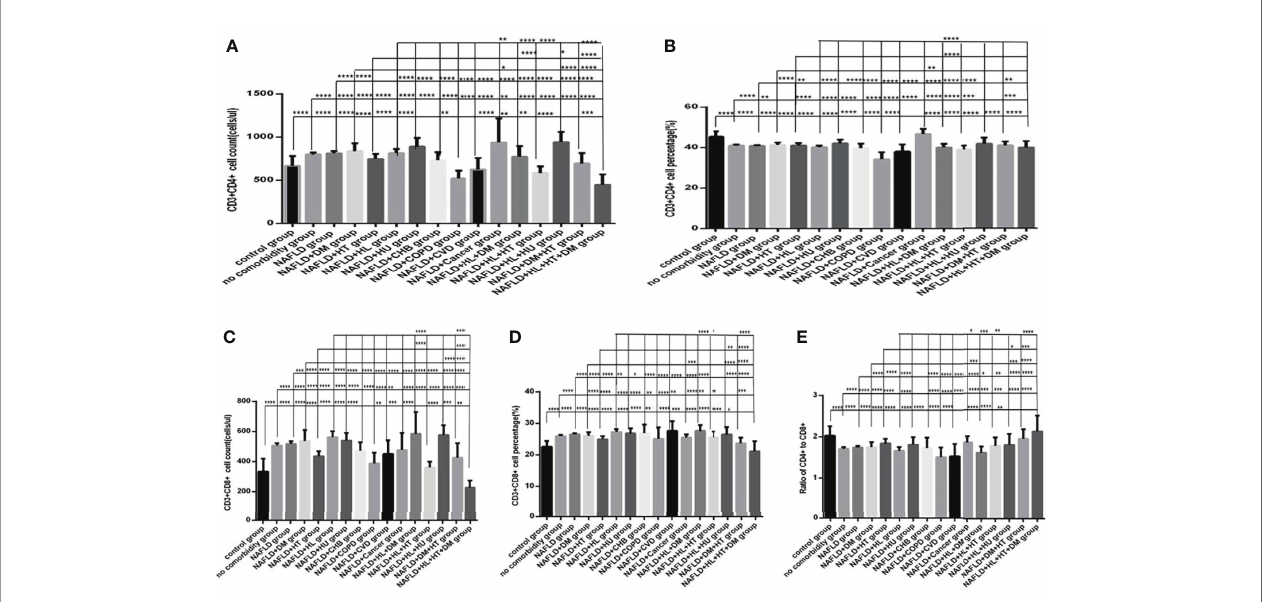
FIGURE 11 | Comparison of T lymphocyte subset counts and percentages among the control group, the no comorbidity group, with NAFLD group and with each combination of NAFLD and other comorbidities group ( n =773; control, no comorbidity, NAFLD, and each combination of NAFLD and other comorbidities group, n =55, 253, 304, 39, 50, 88, 26, 13, 6, 6, 6, 17, 19, 11, 14 and 5 cases, respectively). CHB, chronic hepatitis B.CKD, chronic kidney disease. COPD, chronic obstructive pulmonary disease. COVID-19, coronavirus disease 2019.CVD, cardiovascular disease. NAFLD, nonalcoholic fatty liver disease. DM, diabetes mellitus. HT, Hypertention. HL, heperlipidemia. HU, hyperuricemia and gout. (A) CD3+CD4+ cell count. (B) CD3+CD4+ cell percentage. (C) CD3+CD8+ cell count. (D) CD3 +CD8+ cell percentage. (E) Ratio of CD4+/CD8+ cells. Unpaired one-way ANOVA was used for intergroup comparisons ( A – E , P all < 0.0001). Unpaired t -tests were used for comparisons with the control group, and with the no comorbidity group, with NAFLD group, with NAFLD plus DM group, with NAFLD plus hypertension group, with NAFLD plus hyperlipidemia group, with NAFLD plus hyperuricemia and gout group, * P < 0.05, ** P < 0.01, *** P < 0.001, **** P <